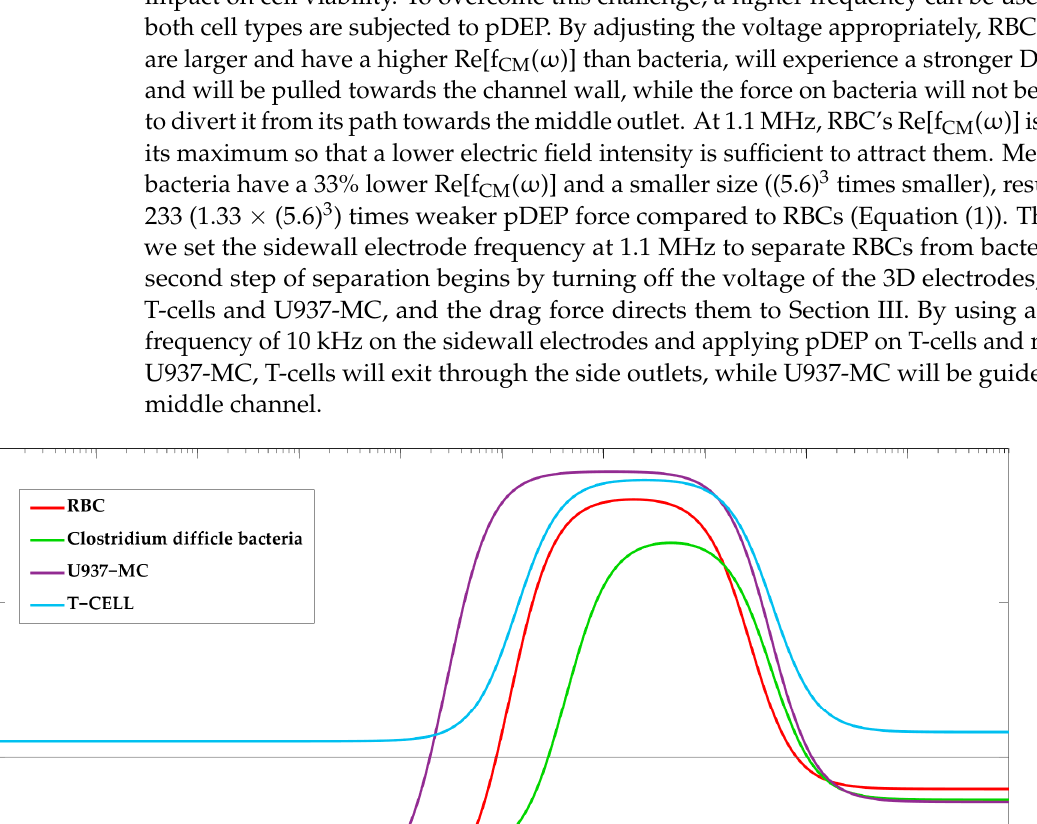
Figure 6. The applied forces on particles at di ff erent y positions.